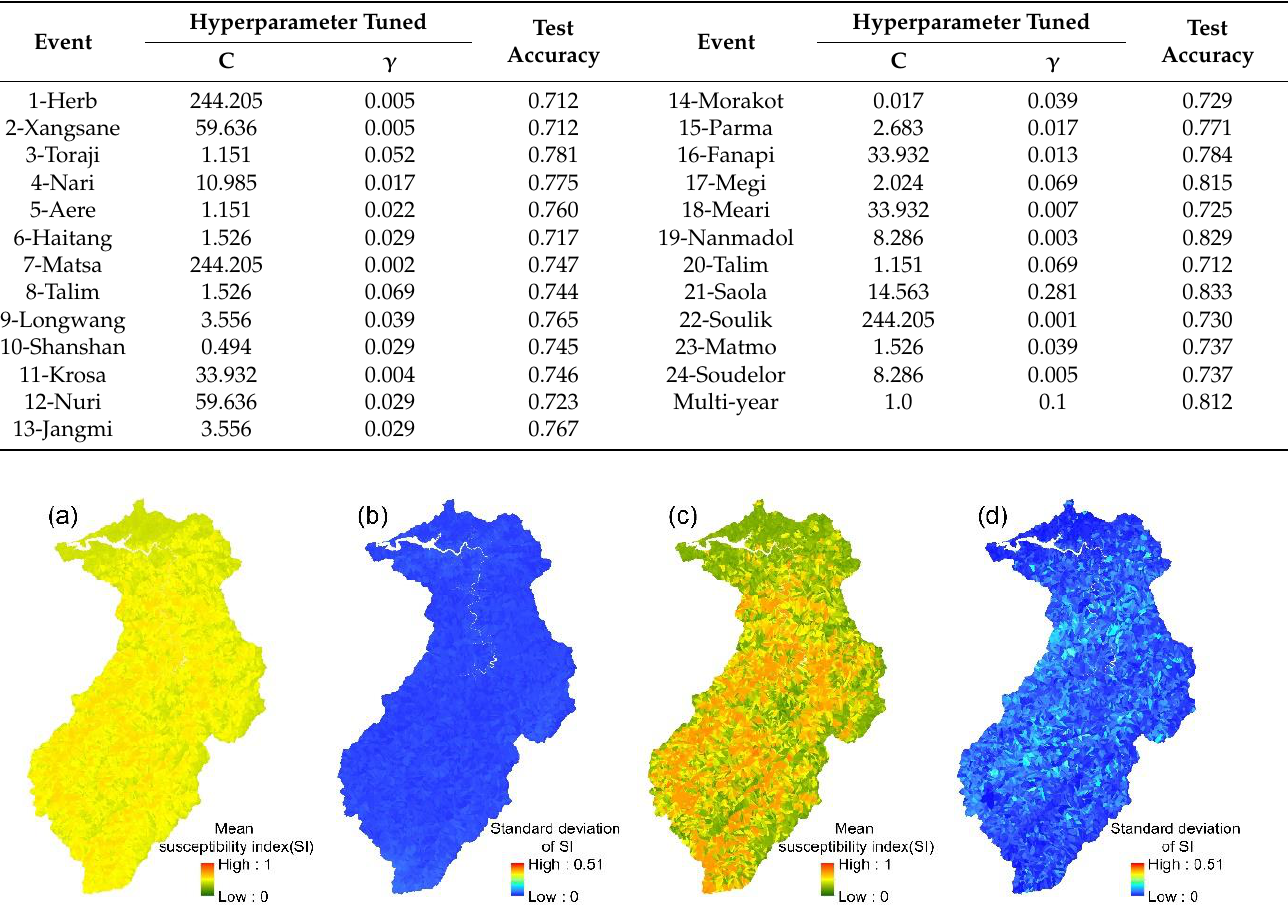
Table 7. The tuned hyperparameters and model performances for KLR models.